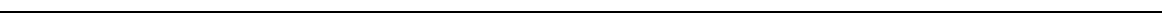
Fig. 5 Pdgfr β + precursors contribute to rosiglitazone-induced adipocyte hyperplasia. a MuralChaser mice were fed on standard chow diet until 6 weeks old before being switched to HFD for 10 weeks. Mice were then administrated with dox-containing HFD (600 mg/kg) for 7 days ( “ pulse ” ). Following the pulse- labeling period, mice were switched back to regular HFD for another 4 weeks during which vehicle (1% methylcellulose) or rosiglitazone (Rosi) (10 mg/kg/ day) was delivered by gavage ( “ chase ” ). Paraf fi n sections of WAT from these animals were stained with anti-GFP (green) and anti-perilipin (red), then counterstained with DAPI (blue; nuclei). b – e Representative ×63 magni fi cation confocal immuno fl uorescence images of gonadal WAT sections after rosiglitazone treatment ( “ chase ” ). * indicates GFP-labeled perilipin-positive cells. Scale bar, 50 μ m. f – i Representative ×63 magni fi cation confocal immuno fl uorescence images of perirenal WAT sections after rosiglitazone treatment ( “ chase ” ). * indicates GFP-labeled perilipin-positive cells. Scale bar, 50 μ m. n Fat pad weight (normalized to body weight) of the indicated fat depots of mice treated with vehicle or rosiglitazone. Student ’ s t -test, * p < 0.05; n = 6 per group. Bars/data points represent mean + s.e.m. o Percentage of perilipin-positive adipocytes expressing GFP in the indicated fat depots of mice treated with vehicle or rosiglitazone. Welch ’ s t -test, * p < 0.05; n = 12 randomly chosen ×63 magni fi cation fi elds from three individual reporter animals. Bars/data points represent mean + s.e.m. p Average adipocyte size and q distribution of adipocyte size in gonadal WAT from mice treated with vehicle or rosiglitazone. Student ’ s t -test, *p < 0.05; n = 6 per group. Bars/data points represent mean + s.e.m. r Average adipocyte size and s distribution of adipocyte size in perirenal WAT from mice treated with vehicle or rosiglitazone. Student ’ s t - test, * p < 0.05; n = 6 per group. Bars/data points represent mean + s.e.m. t Average adipocyte size and u distribution of adipocyte size in inguinal WAT from mice treated with vehicle or rosiglitazone. n = 6 per group. Bars/data points represent mean +